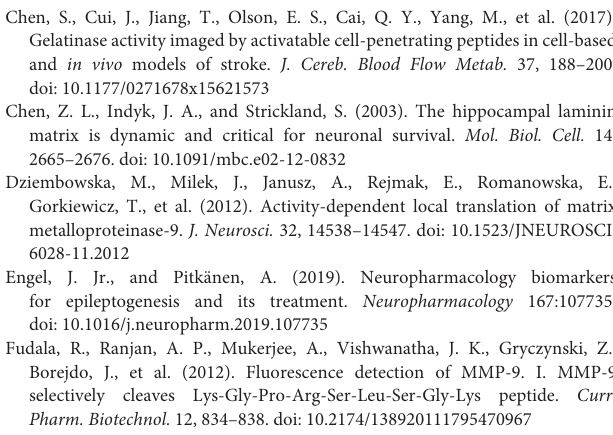
FIGURE S1 | Anti-beta-dystroglycan Western Blot of stimulations of endogenous gelatinases in cultured neurons. FIGURE S2 | Anti-GAPDH Western Blot (loading control) of stimulations of endogenous gelatinases in cultured